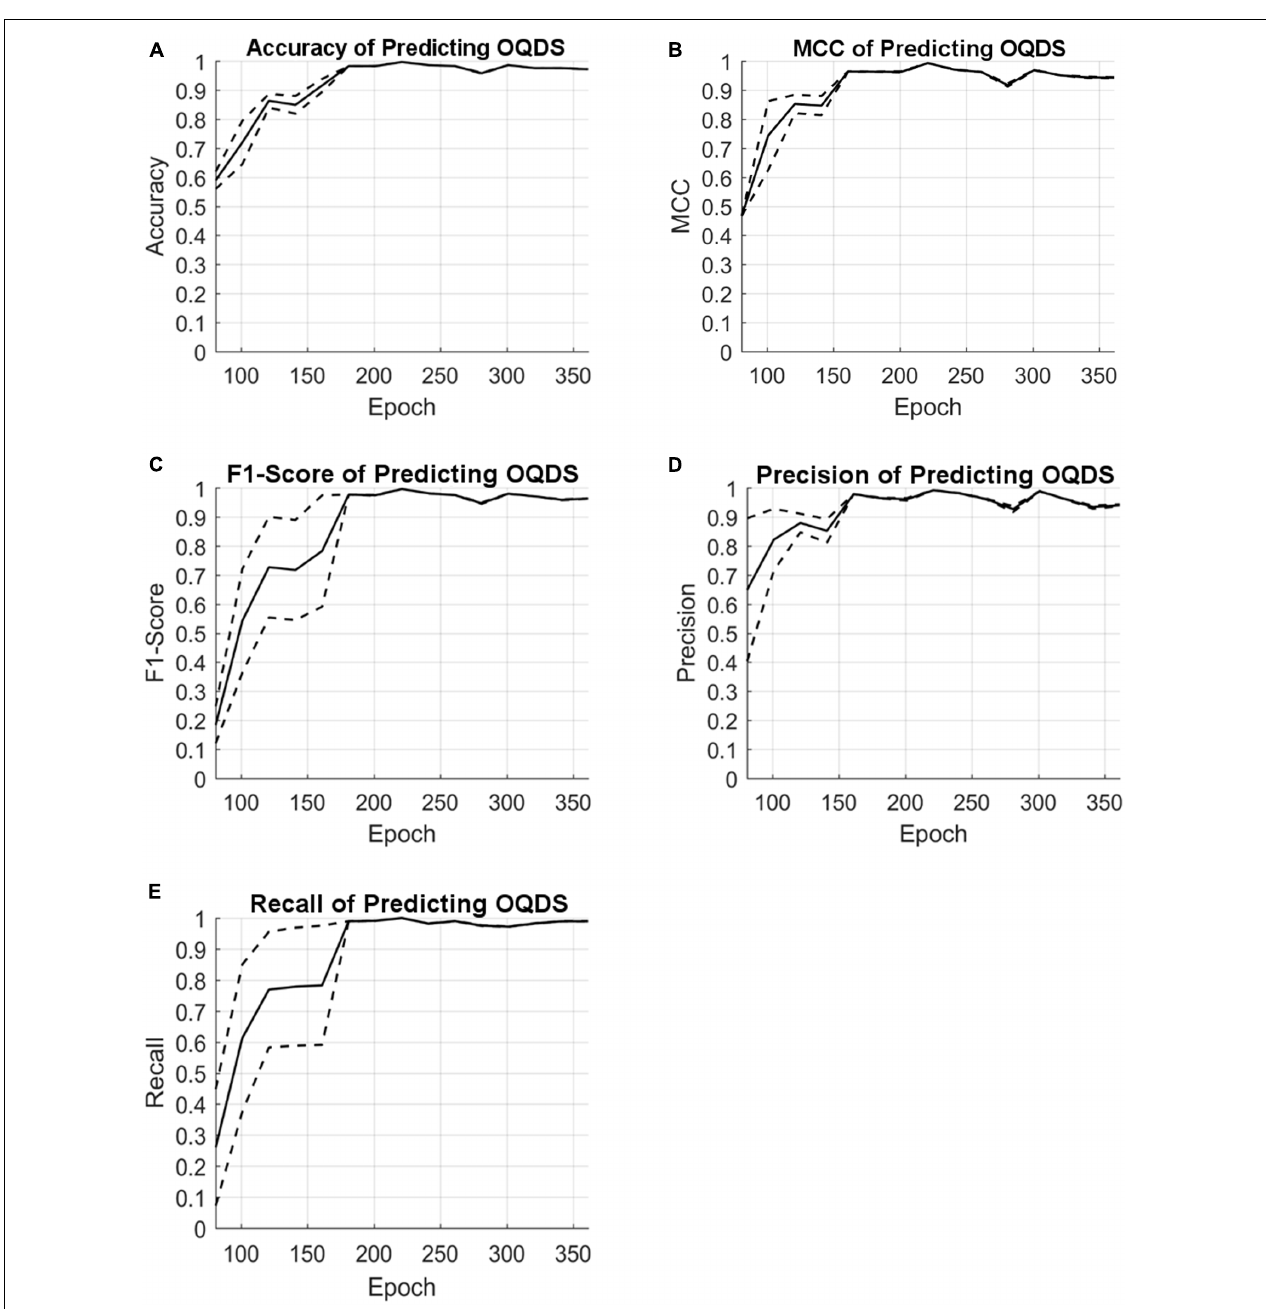
FIGURE 5 | (A) Accuracy, (B) Matthew’s Correlation Coefficient (MCC), (C) F1-Score, (D) precision and (E) recall of predicting symptoms of Olive Quick Decline Syndrome (OQDS) in images of X. fastidiosa -positive leaves of O. europaea L. amongst healthy controls (asymptomatic leaves) or X. fastidiosa -negative leaves showing other disorders. Higher is better for all